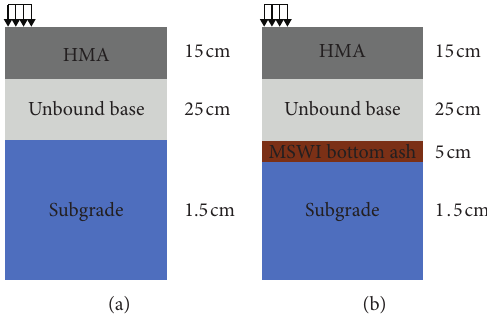
Figure 4: Pavement structure in the finite element